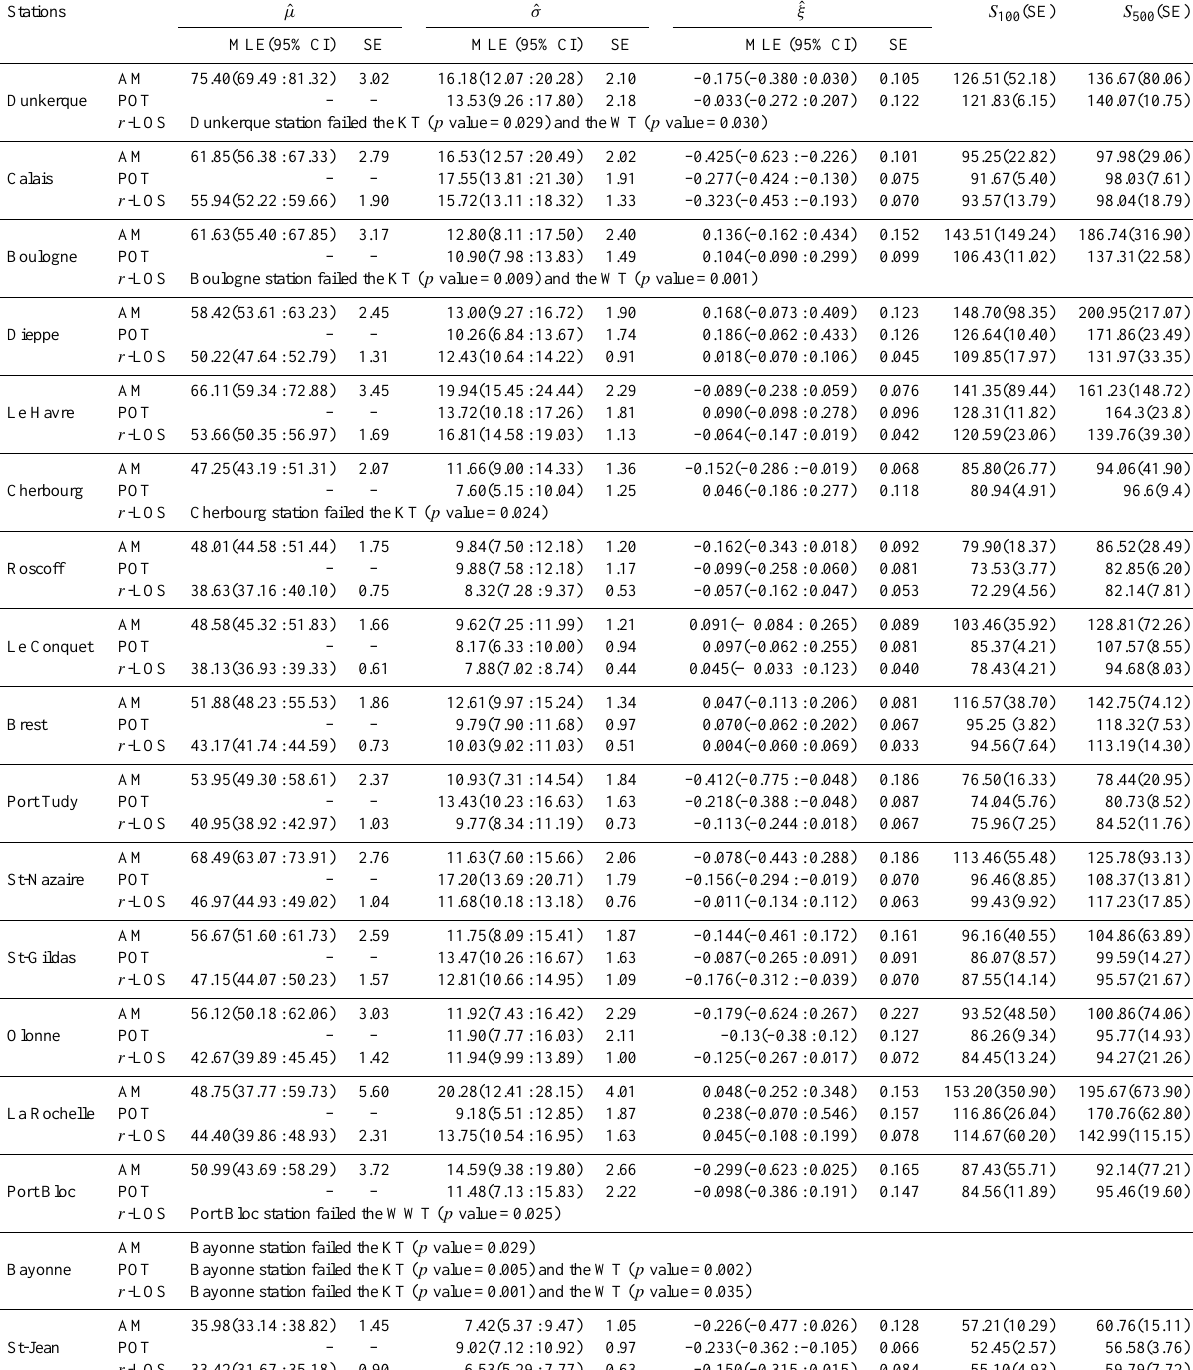
Table 2. MLEs and return levels with associated standard errors for GEV distribution using AM and r -LOS data (with optimum choice of r ) and for GPD using POT data (with optimum choice of u